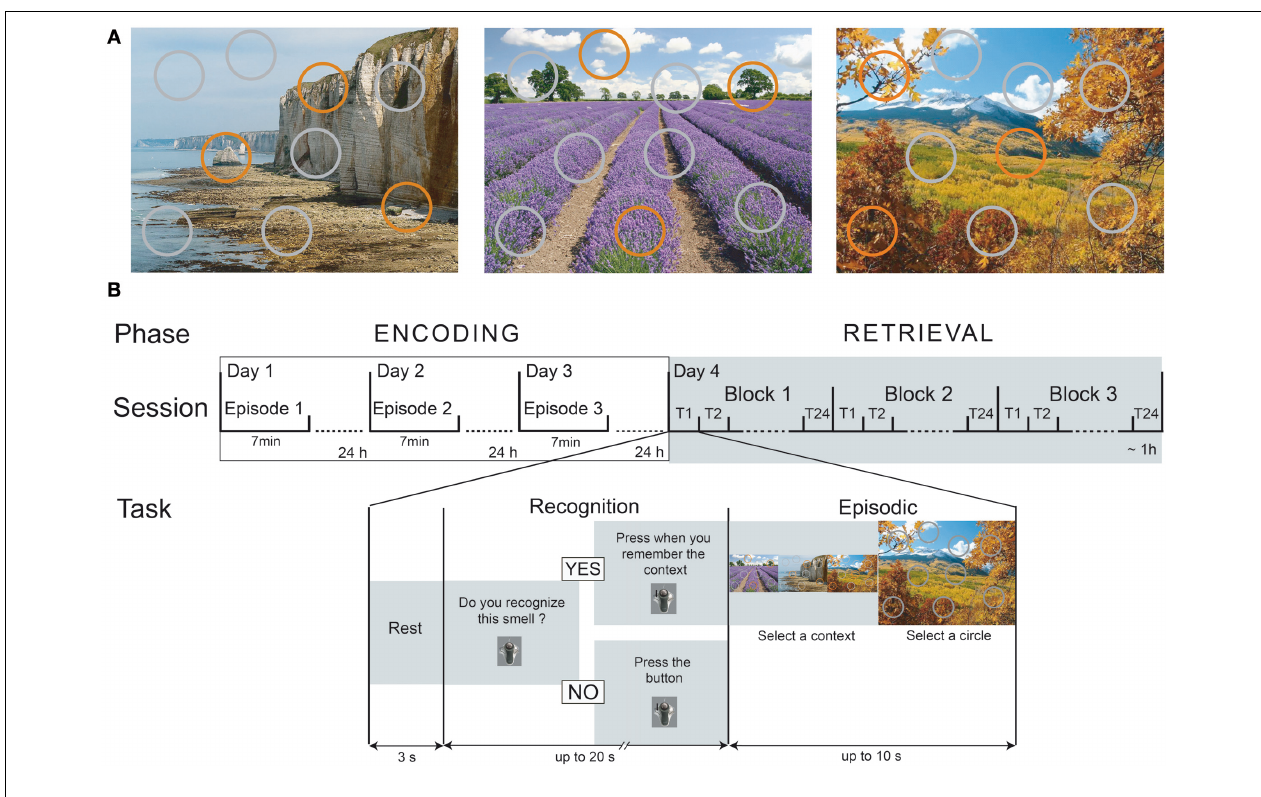
FIGURE 1 | Episodic-memory task design. (A) The three spatio-contextual environments of the episodes. Orange circles represent the spatial locations associated with an odor. (B) The temporal course of the encoding and retrieval sessions. During the